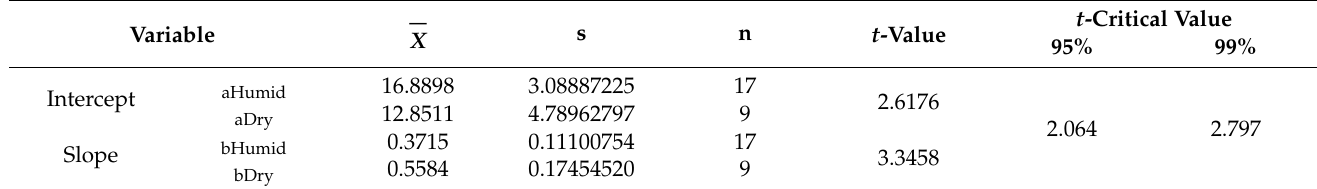
Table 9. Results of Student’s t- test for the analyzed comfort equations.